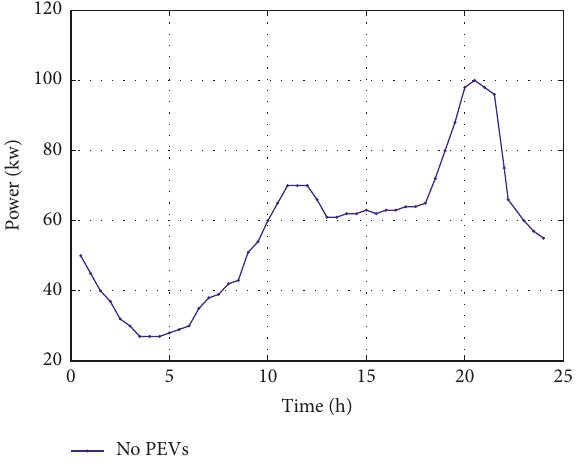
Figure 1: Daily power curve without